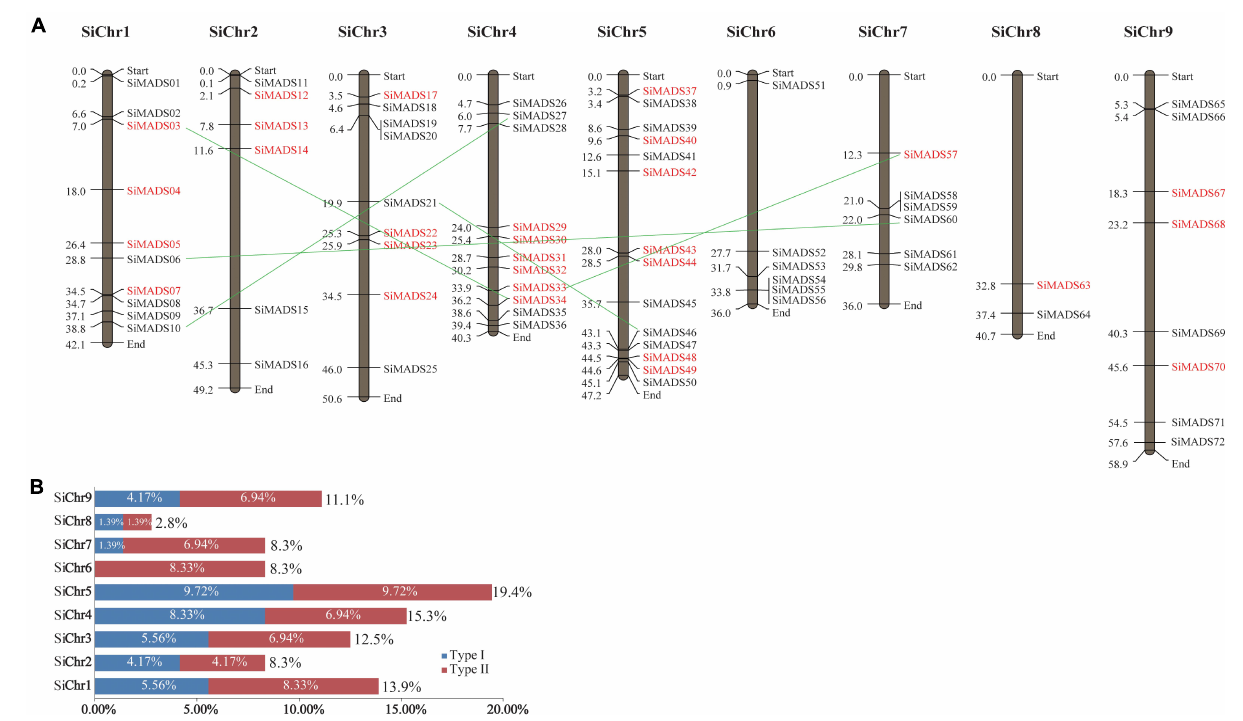
FIGURE 2 | Chromosomal location of foxtail millet MADS-box genes. (A) The 72 SiMADS-box genes distributed on the nine foxtail millet chromosome. Type I and type II genes are colored red and black, respectively. The duplicated genes are connected by green lines between the two relevant chromosomes. (B) The percentages of SiMADS-box genes on each chromosome.